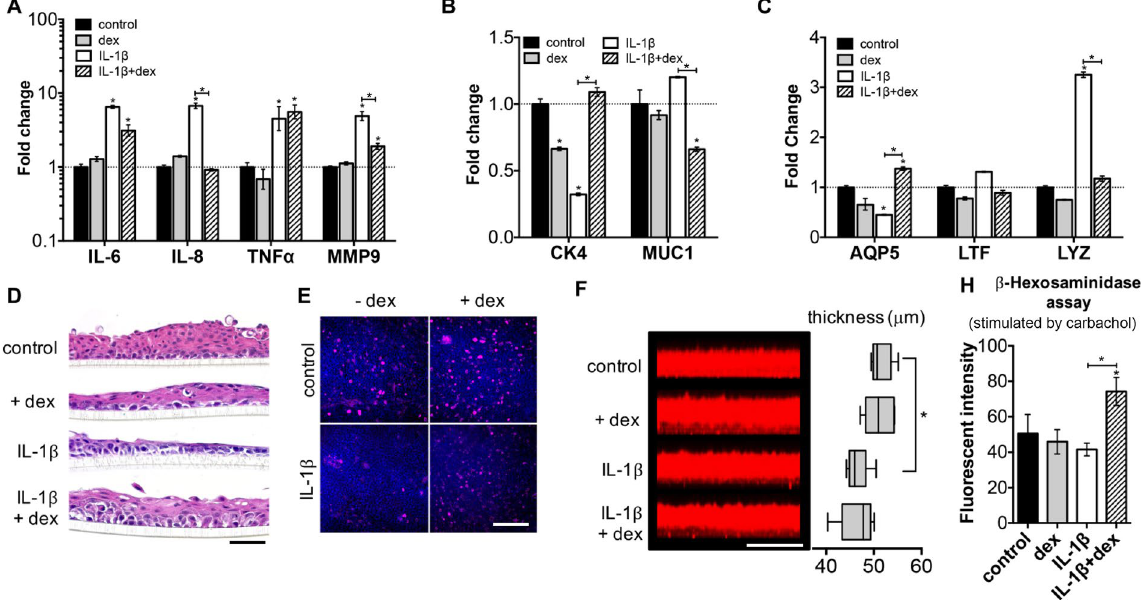
Figure 6. Responses of direct cell contact model after cytokine IL-1 β stimulation. ( A – C ) Gene expression of the coculture system after the addition of IL-1 β . ( A ) Inflammatory genes; ( B ) conjunctival epithelial specific genes; ( C ) lacrimal gland specific genes. ( D ) The change of epithelial thickness and morphology (H&E staining) after IL-1 β exposure. Scale bar 100 μ m. ( E ) MUC5AC staining of the airlifted CECs under various conditions (top view). Scale bar 200 μ m. ( F ) Mucin layer secreted by airlifted CECs imaged by confocal z-scanning. The thickness values were measured using ImageJ. Scale bar 100 μ m. ( H ) β -hexosaminidase assay (supernatant of LG cell spheroids culture; measured by fluorescent intensity). Dexamethasone: dexamethasone, used as a treatment to inflammatory caused by IL-1 β . * p < 0.05; ** p < 0.001. Significance indicates comparison with the control group if not stated